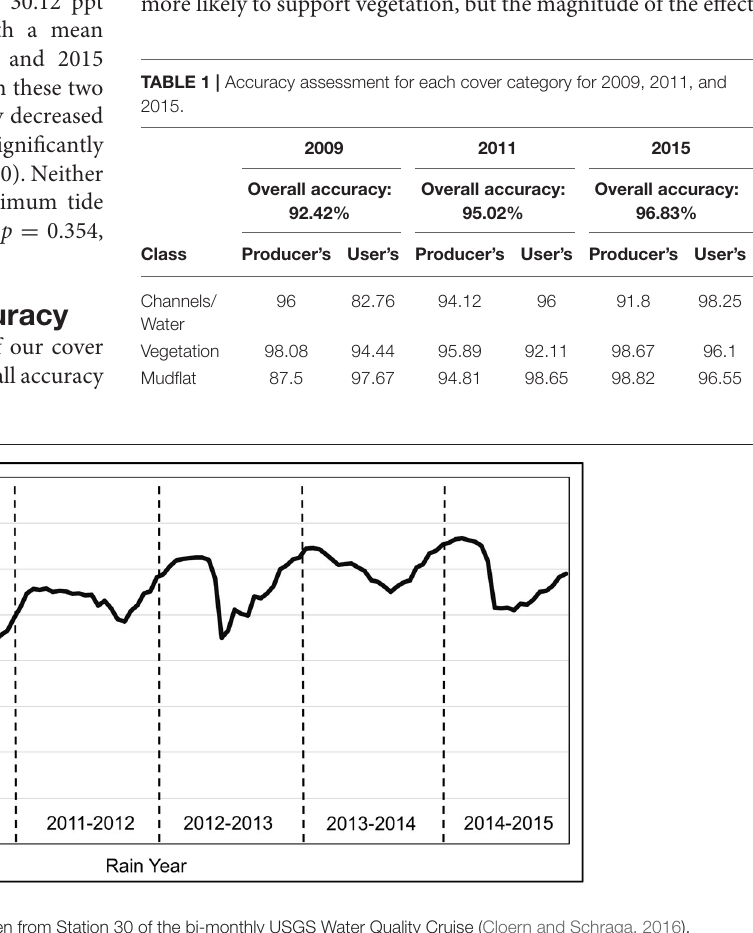
FIGURE 2 | SF Bay Salinity, rain years 2009–2015. Data were taken from Station 30 of the bi-monthly USGS Water Quality Cruise (Cloern and Schraga, 2016).